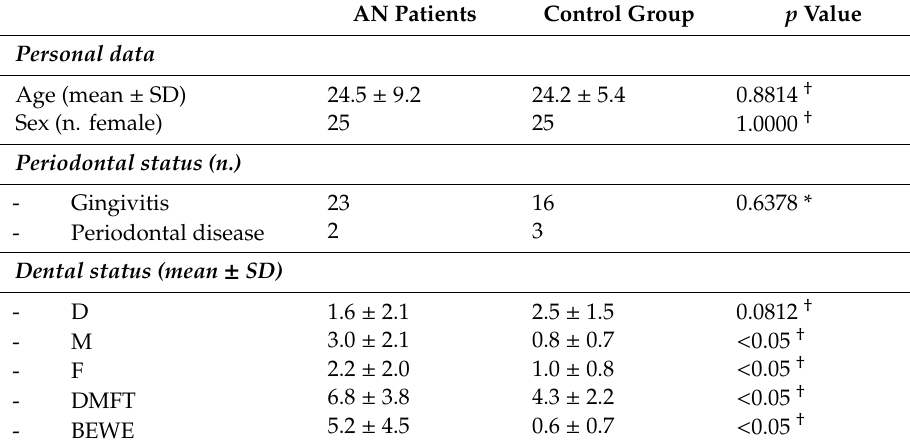
Table 2. Comparison between AN patients and control